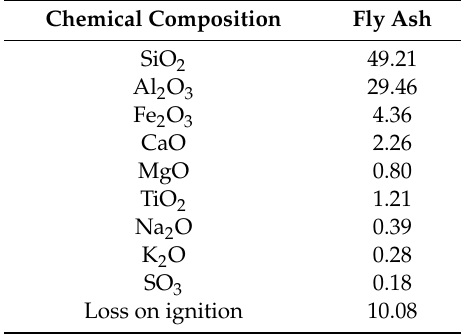
Table 1. Chemical composition of fly ash (wt.